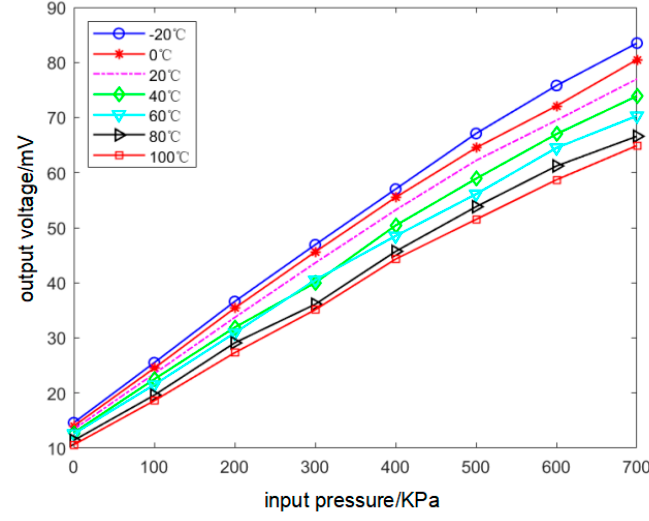
Figure 6. Output 2 − D curves of Sensor A.